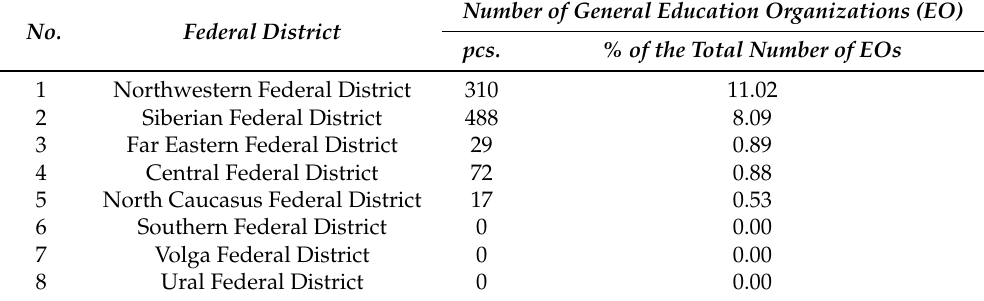
Table 4. The number of general education institutions using information resources for the automated development of menus in the federal districts of the Russian